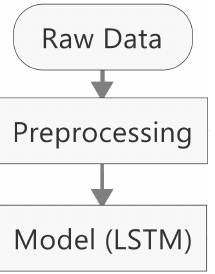
Figure 9. Flowchart of the LSTM